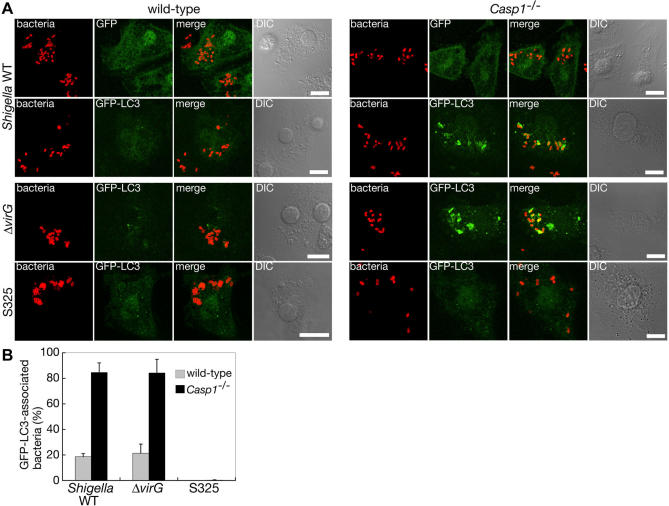
Caspase-1 Deficiency Promotes Autophagosome Maturation in Macrophages Infected with Shigella Independently of VirG ProteinGFP-LC3-expressing wild-type or caspase-1-deficient BMMs were infected with Shigella WT, ΔvirG, or TTSS mutant S325. As a control, GFP alone expressing wild-type or caspase-1-deficient BMMs were infected with Shigella WT.(A) At 30 min after infection, the infected cells were immunostainted with Cy5-labeled anti- Shigella LPS antibody (colored red) and examined using a confocal microscope. The merged image with Cy5 bacteria and GFP fluorescence, and differential interference contrast (DIC) were also shown. Scale bars = 10 μm.(B) GFP-LC3-associated intracellular bacteria were quantified. Error bars represent mean ± SD.